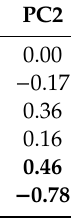
Table 3. Component correlation coe ffi cients in the principal component analysis (PCA) of the sediment variables and the first two components (PC1 and PC2 = 67.6% and 23.9% of variance, respectively).